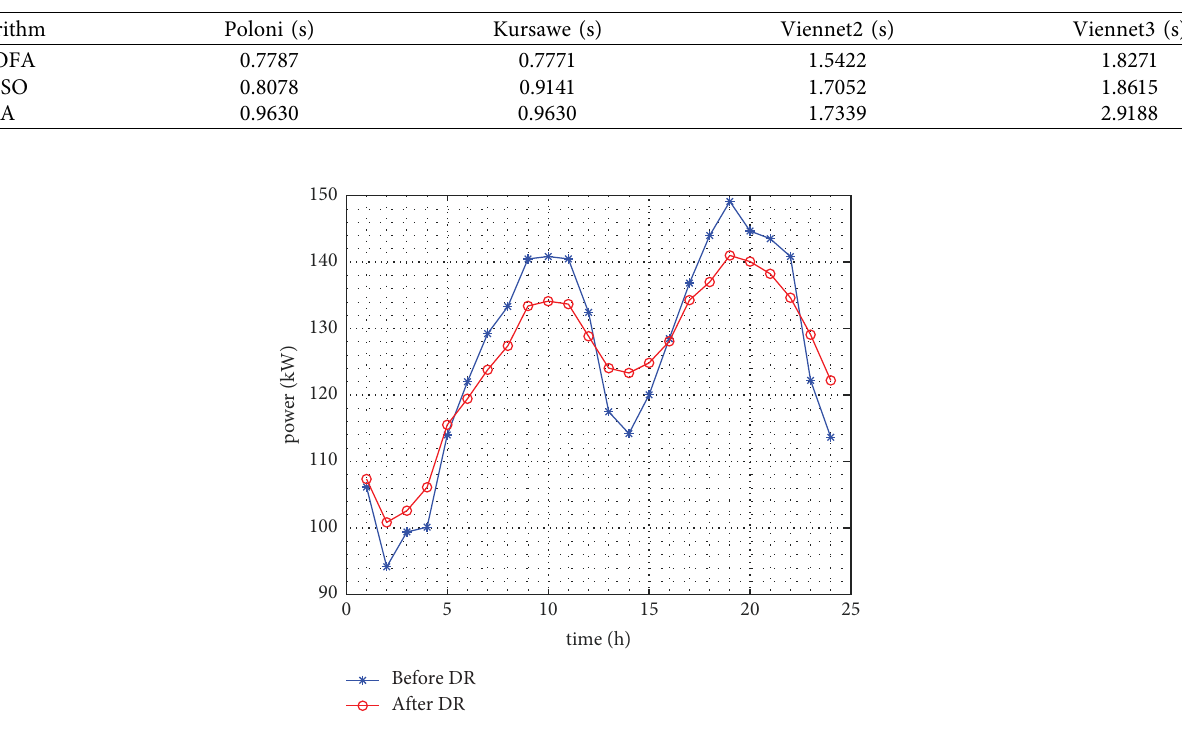
Table 3: ART evaluation index.